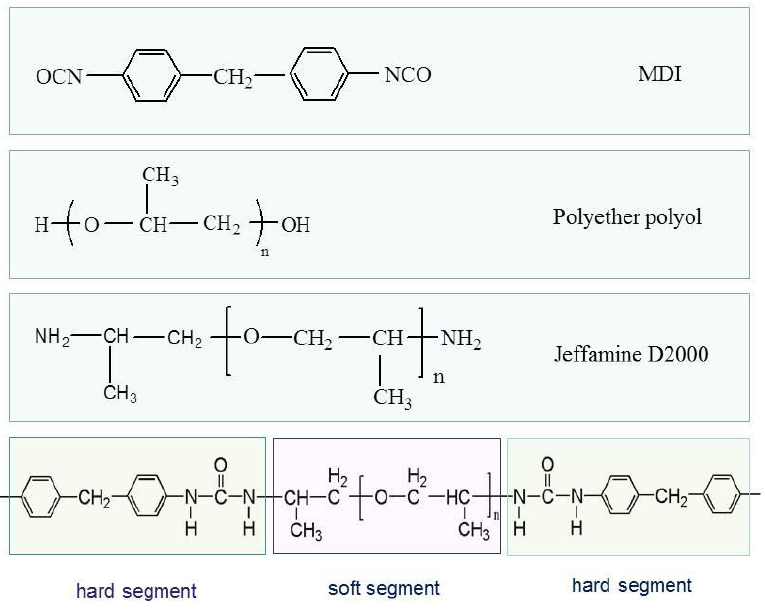
Figure 1. Molecular structures of polyurea precursors.